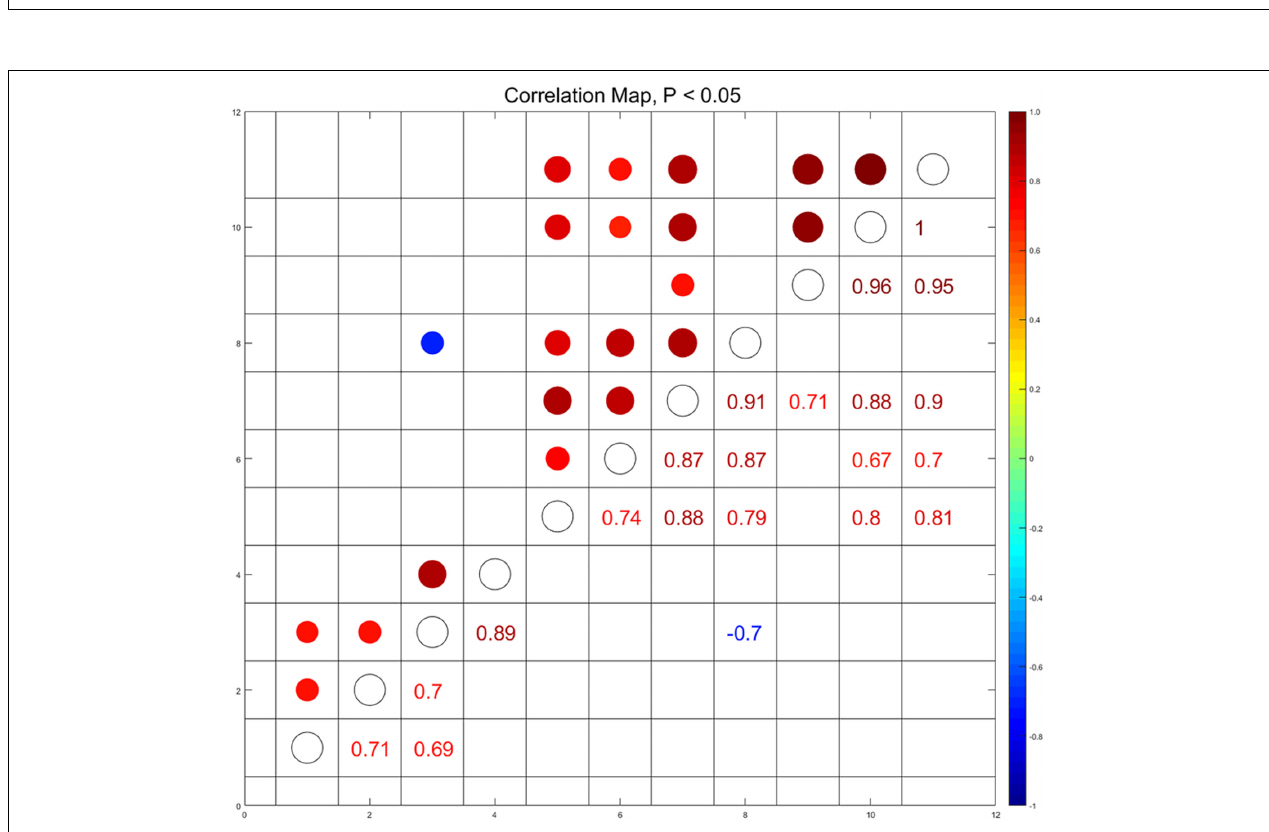
FIGURE 9 | Correlations among immunometabolic signals presented as the activation of AMPK-ERK in the PFC and the hippocampus, cytokines in the sera, and the social behavioral parameters (p < 0.05). Through pairwise comparison of the social behavioral index and biochemical indicators, we selected and displayed those with p -value less than 0.05, and used the area and color depth of the dot to represent the r -value. (1): Time around the target in the sociability session of Three-Chamber Test (TCT); (2): Preference index in the sociability session; (3): Time around the target in the test session of preference for social novelty; (4): Preference index in the test session of preference for social novelty; (5): the level of p-ERK/ERK in the hippocampus; (6): the level of p-AMPK α /AMPK α in the hippocampus; (7–11): the serum level of CXCL13 (7), C5 (8), CXCL12 (9), M-CSF (10), and TIMP-1 (11).